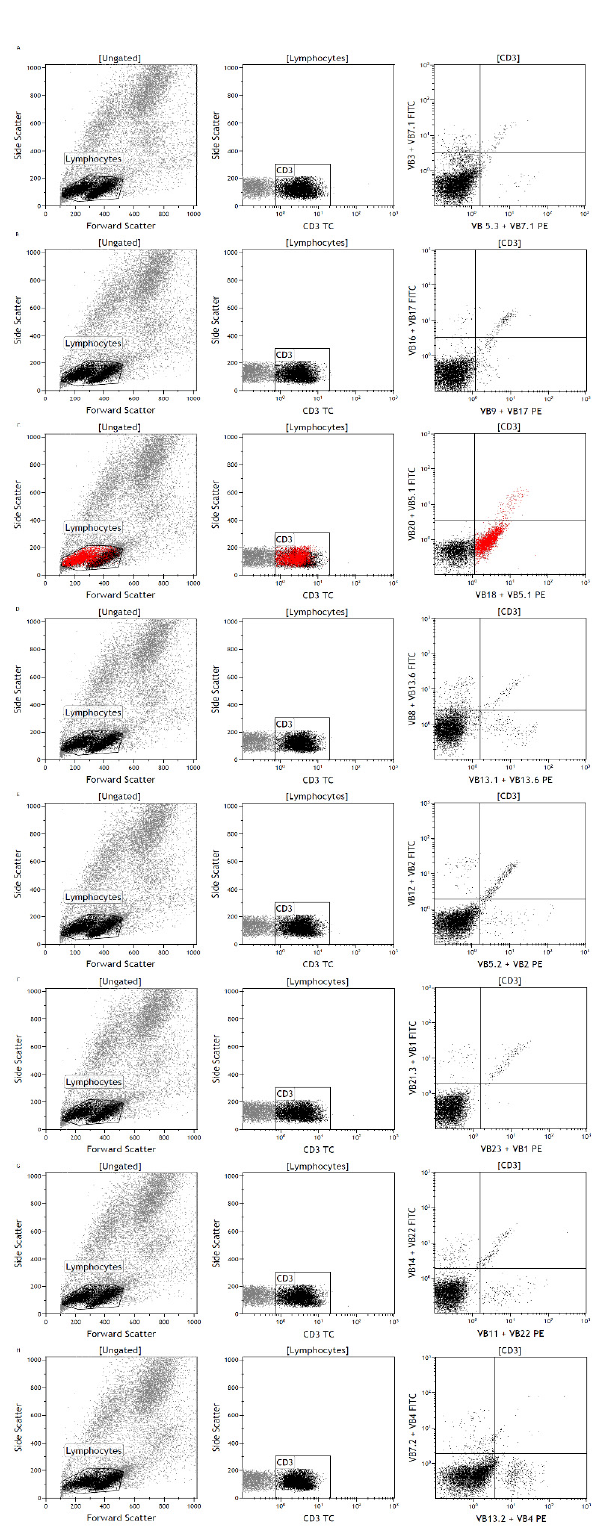
Figure 2. Clonal V beta T-cell receptor expansion on the aberrant cell population. In each row, gating on lymphocytes and CD3-positive cells (colored black) is shown (left and middle). On the right, analysis of Vß TCR of the CD3-positive cells is depicted. In row C, Vß TCR in Vß20 / Vß5.1 versus Vß18 / Vß5.1 is shown on the right. Monoclonal expression of Vß18 is clearly visible (colored